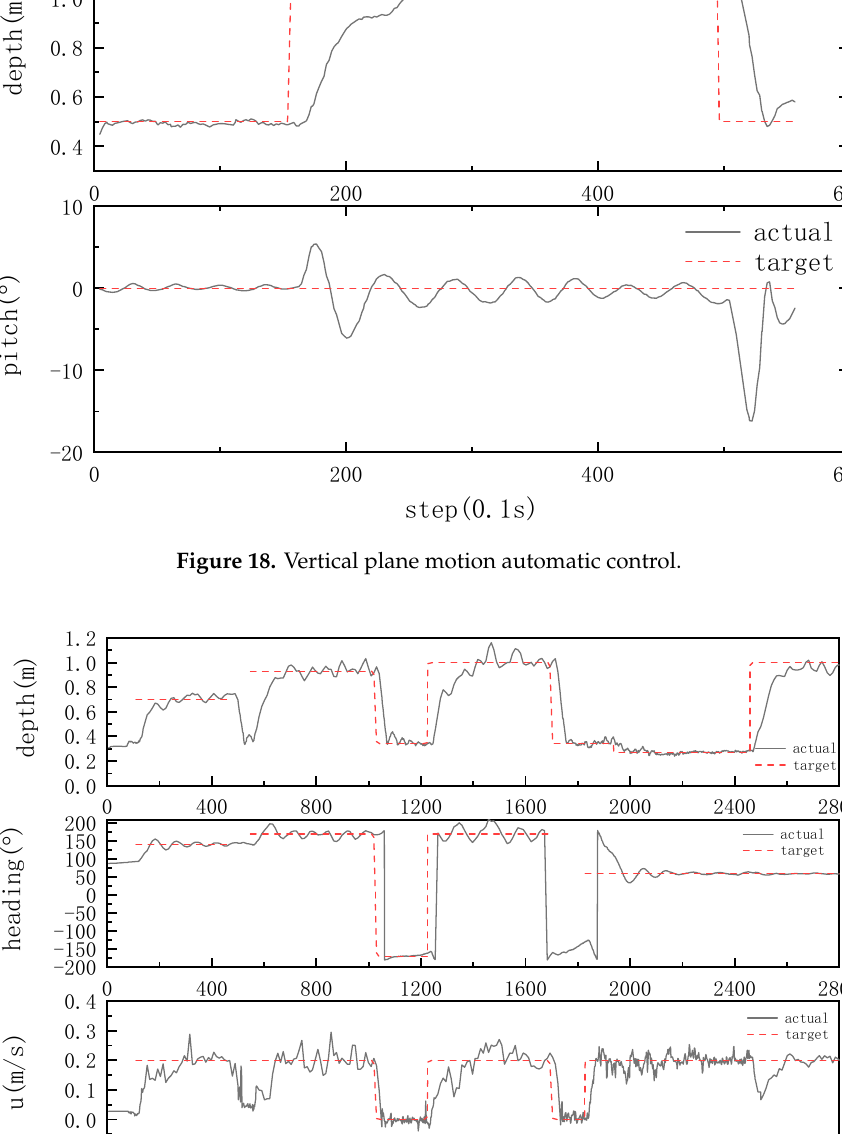
Figure 19. Experimental result of automatic control.